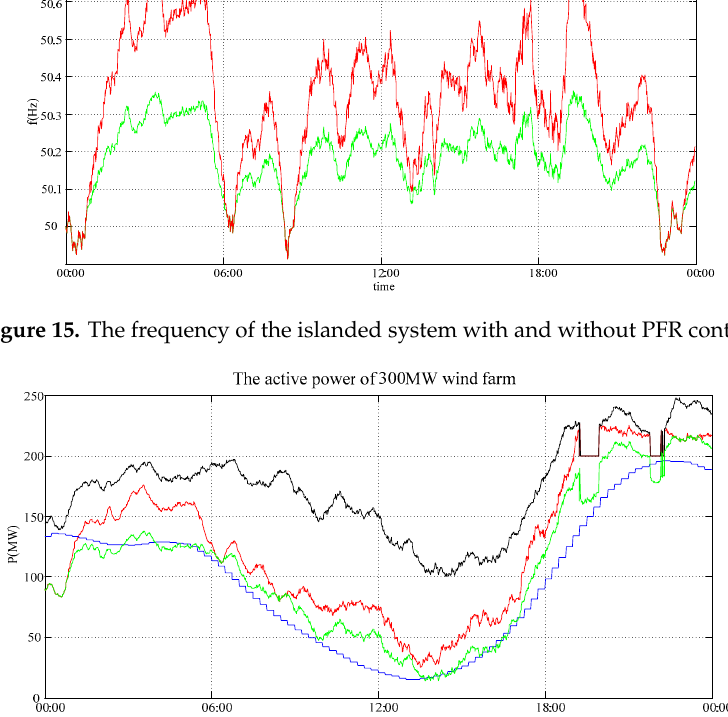
Figure 14. The basic power, and actual power with and without PFR of VSC station B and the C − F transmission line.